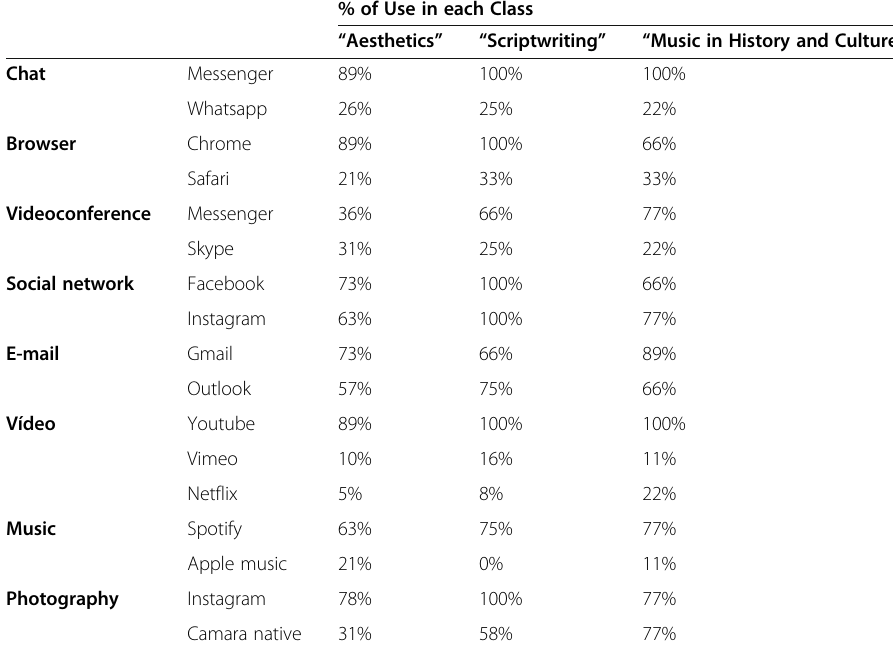
Table 3 Application data usage